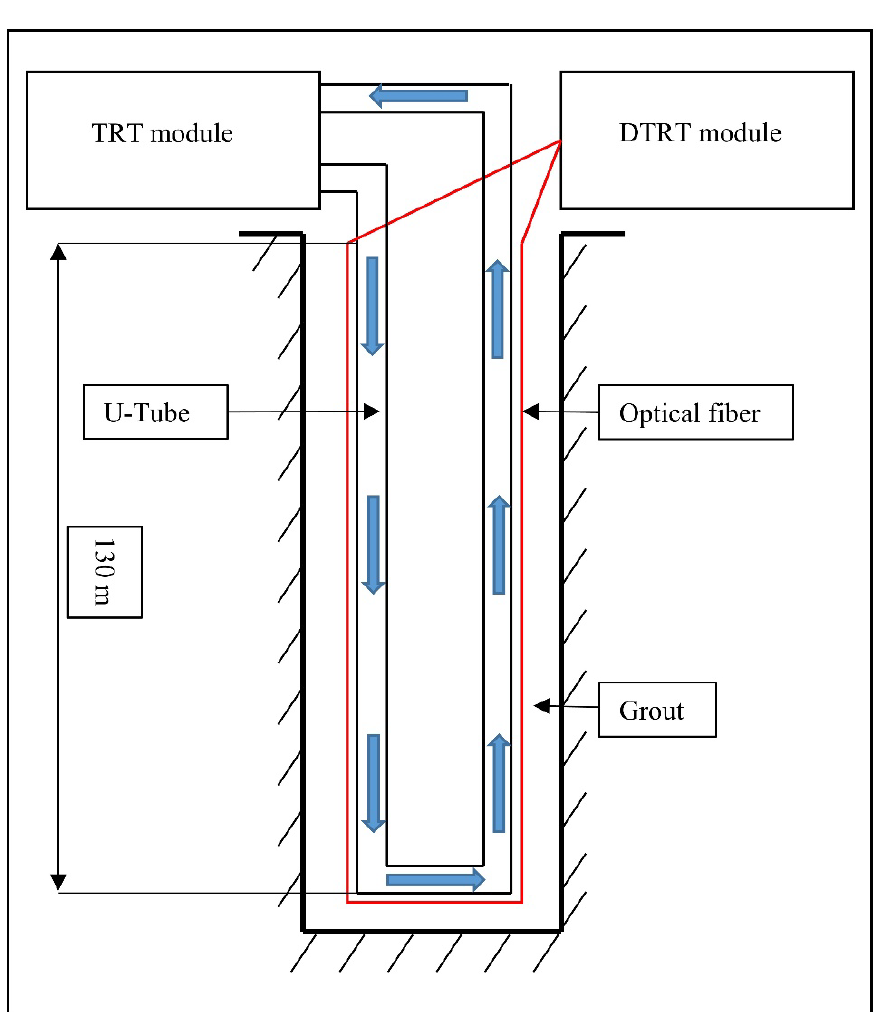
Figure 2. Schematic diagram of the combined thermal response test system.